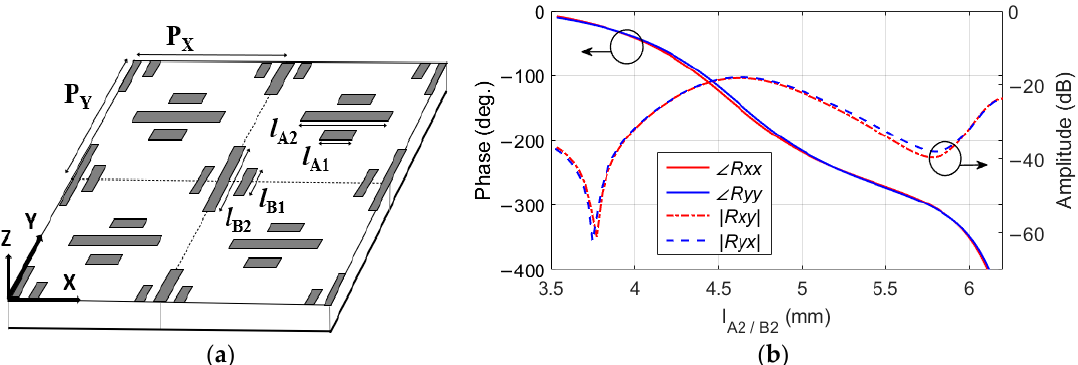
Figure 11. ( a ) Reflectarray cells formed by orthogonal sets of dipoles for controlling each linear polarization (LP): 2 × 2 periodic cells, ( b ) co-polar reflection phases and cross-polar reflection amplitudes at 20 GHz and under θ i = 30°, φ i = 30° oblique incidence.